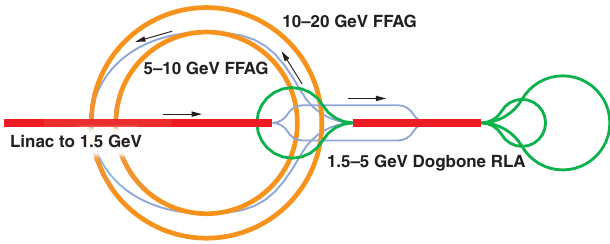
FIG. 19. (Color) Potential layout for the acceleration